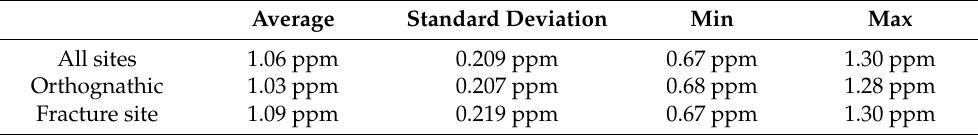
Table 3. Statistical analysis of the results of the soft tissue surrounding the titanium plates. Average Standard Deviation